Question: Which kind of chart has been used to present this data?
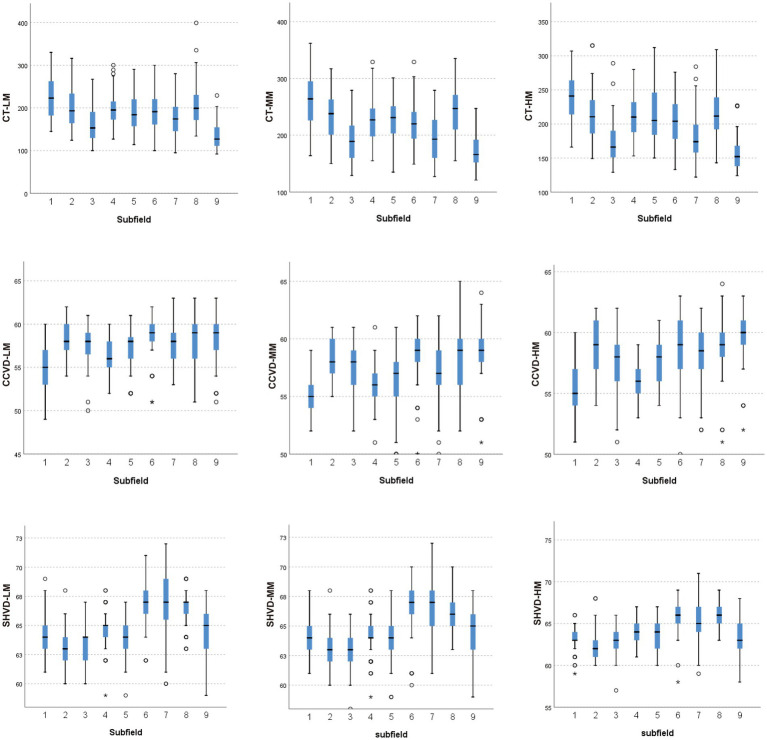
Answer: box